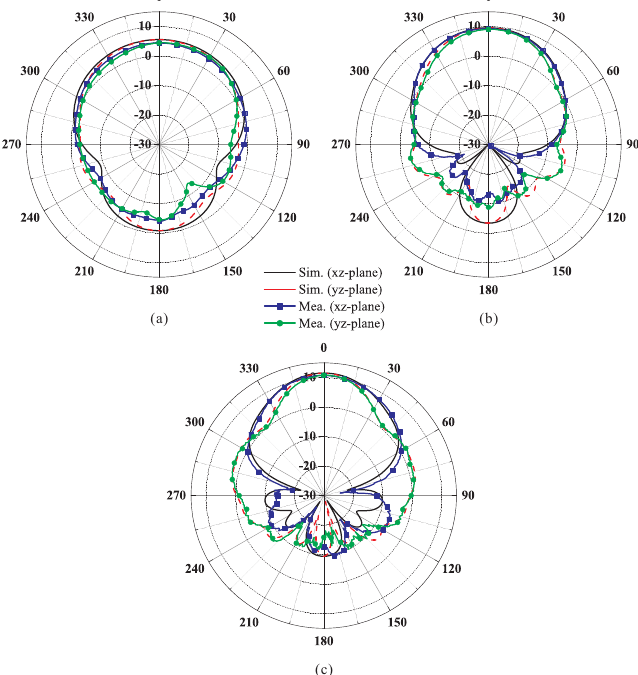
Figure 12. Simulated and measured radiation patterns of the robustly optimized TEM horn antenna: ( a ) at 6 GHz; ( b ) at 12 GHz; and ( c ) at 18